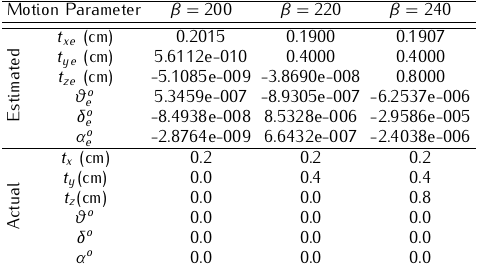
rameters (Translational Motion corrupted case). Motion Parameter